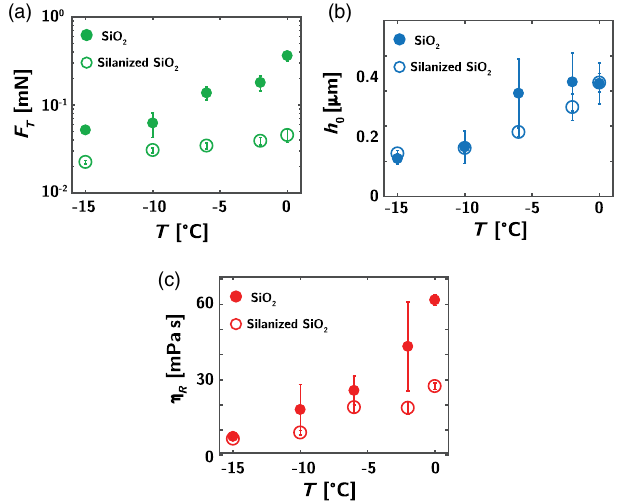
FIG. 5. Effects of the hydrophobic coatings. (a) Comparison of the friction force for a silanized sphere and bare glass for U ¼ 2 . 8 cm s − 1 as a function of temperature. We measure a drastic reduction of friction for the hydrophobic glass sphere. (b) Com- parison of the film thicknesses between the hydrophilic and hydrophobic coatings, showing similar thicknesses. (c) Compari- son of the dissipative part of the viscosity: at high temperatures, the hydrophobic coating is characterized by a lower viscosity η R , in line with the observed reduced friction. The effect is reduced at lower